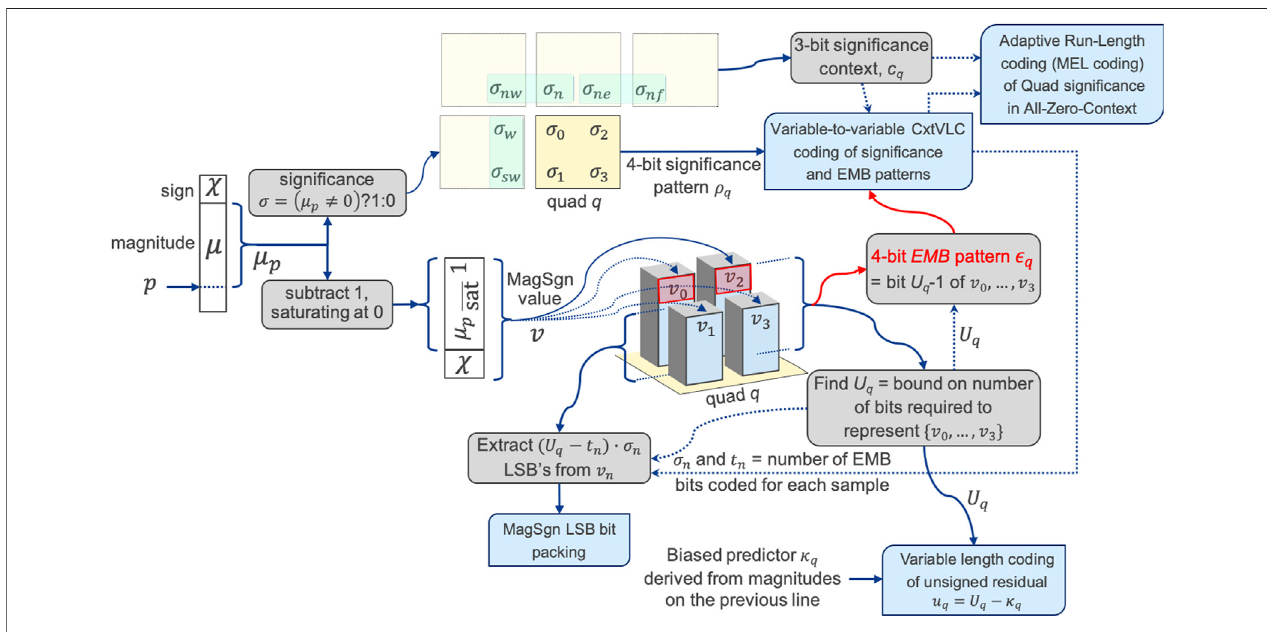
FIGURE 3 | Main elements of the HT Cleanup encoding